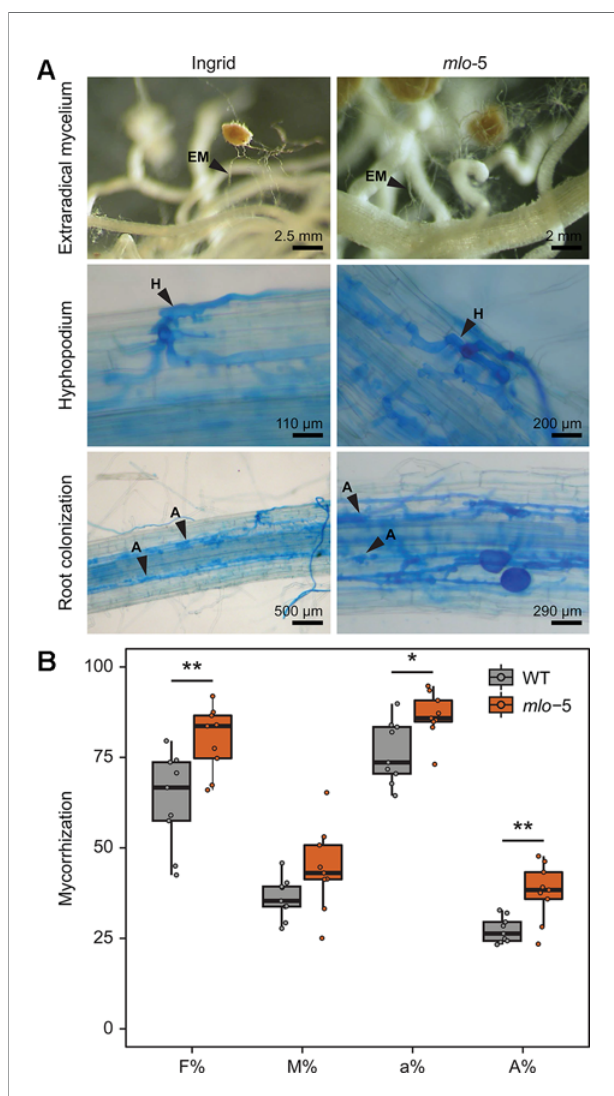
FIGURE 3 | The barley mlo- 5 allele promotes mycorrhization. Three-day-old seedlings were inoculated with F. mosseae inoculum with ≥ 10 active propagules/g mixed into the soil. After 2 months of cultivation, intraradical colonization was assessed by light microscopy of Cotton blue-stained root tissue in WT and mlo- 5 plants (A) . Black arrowheads indicate extraradical mycelia (EM; upper panel), hyphopodia (H; middle panel), and arbuscules (A; lower panel). (B) Mycorrhization was quanti fi ed using root tissue stained with fl uorescein isothiocyanate-conjugated Wheat Germ Agglutinin (WGA-FITC) following confocal microscopy ( n = 2). F% reports the percentage of segments showing internal colonization, M% indicates the average percent colonization of root segments, a% quanti fi es the average presence of arbuscules within the infected areas, A% quanti fi es the presence of arbuscules in the whole root system. Statistically signi fi cant differences in mycorrhization between barley genotypes were determined with Welch two sample t tests (* p < 0.5, ** p <